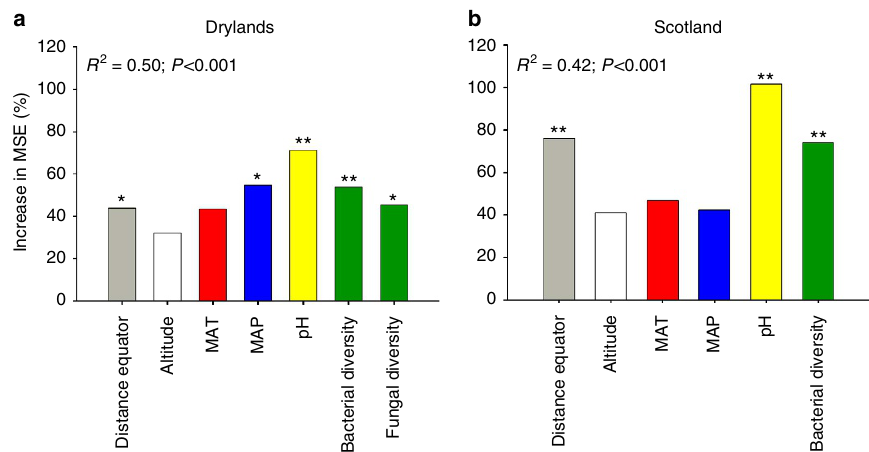
Figure 2 | Main predictors of ecosystem multifunctionality. The figure shows the Random Forest mean predictor importance (% of increase of MSE) of environmental drivers and microbial diversity (Shannon index, bits) on ecosystem multifunctionality for the Drylands ( a ) and Scotland ( b ) data sets. Significance levels of each predictor are as follows: * P o 0.05 and ** P o 0.01. MAT, mean annual temperature; MAP, mean annual